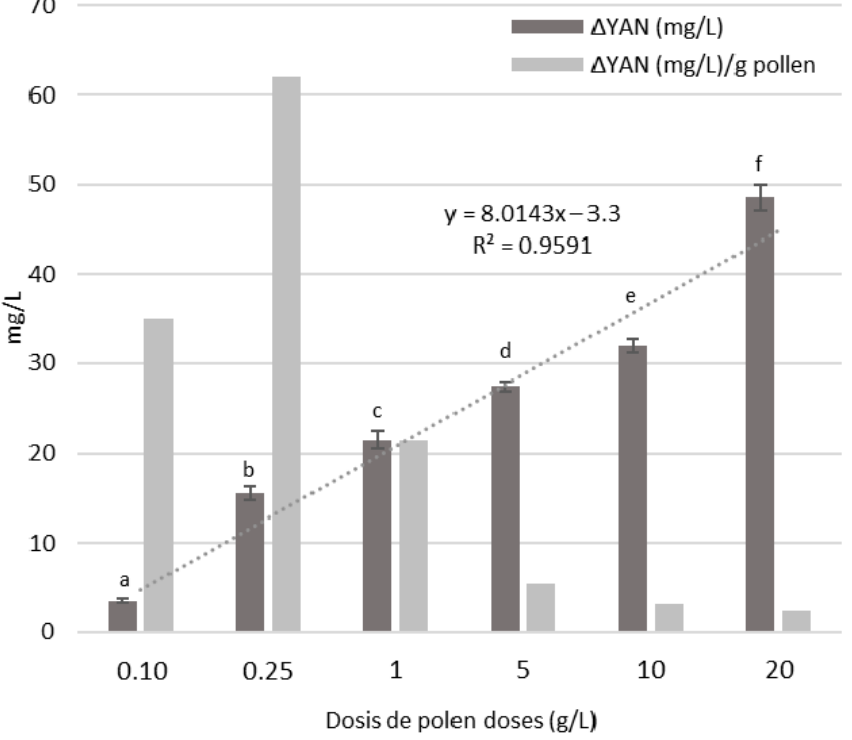
Figure 1. Comparison of the increase in yeast assimilable nitrogen (YAN) per pollen dose versus the increase in YAN produced per gram of bee pollen in red Tintilla de Rota grape-must. Different letters mean significant differences between samples (ANOVA, p < 0.05).